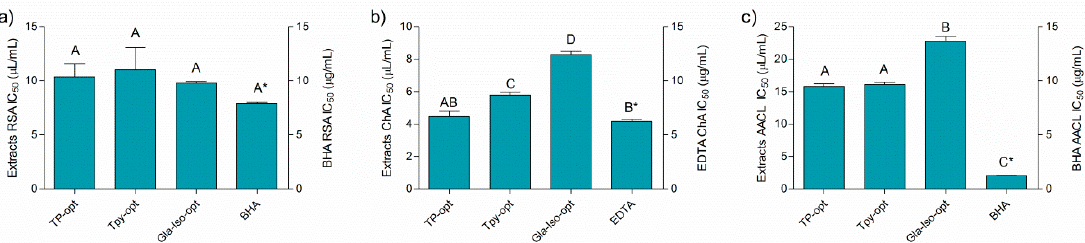
Figure 2. Antiradical ( a ), chelating ( b ), and activity in β -carotene-linoleic acid assay ( c ) and positive controls BHA (butylated hydroxyanisole) and EDTA (ethylenediaminetetraacetic acid). Different uppercase letters indicate statistical significance ( p < 0.05). Asterisk (*) indicates that the IC 50 unit is placed on the right y-axis.